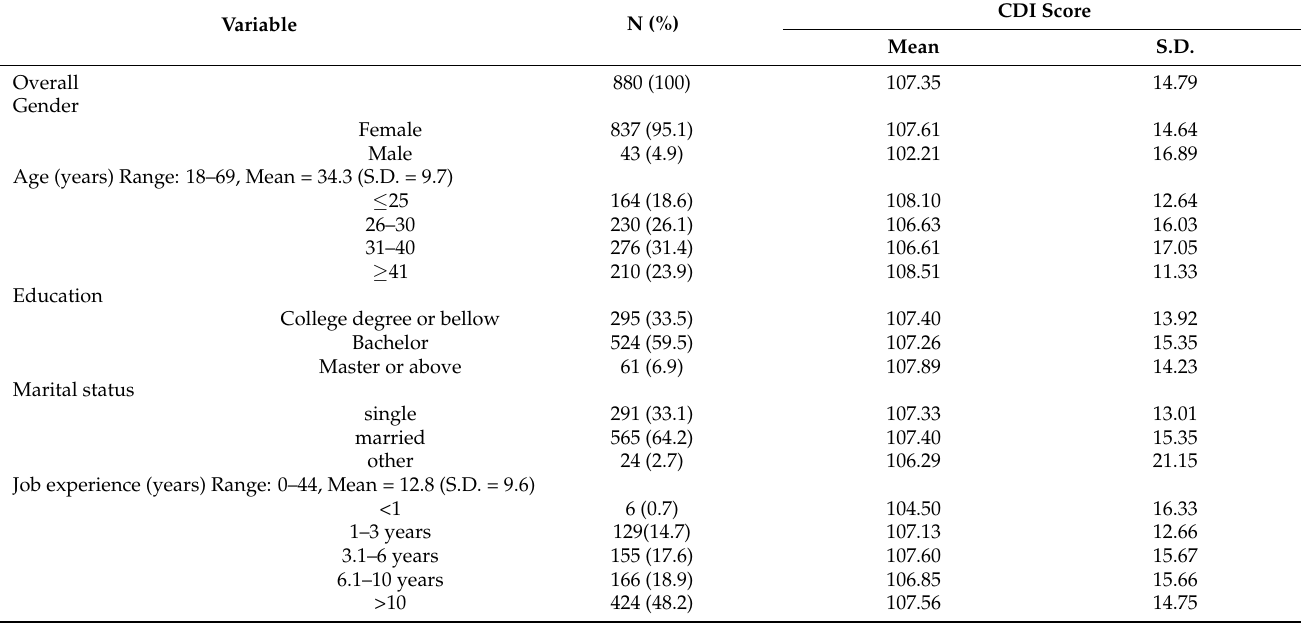
Table 1. Summary of demographic data, and CDI mean score (N =